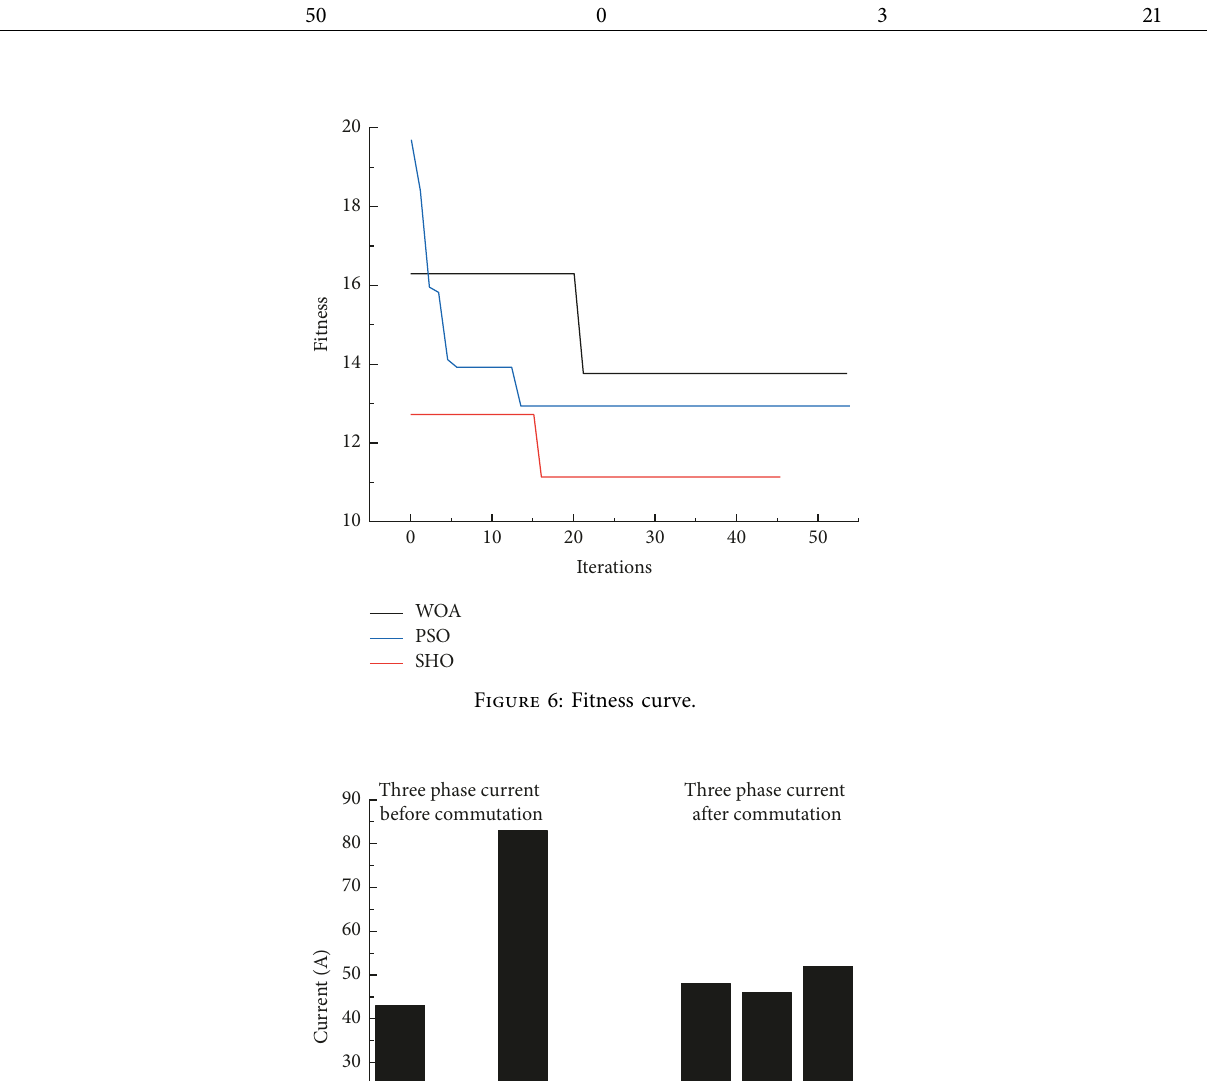
Figure 6: Fitness curve.